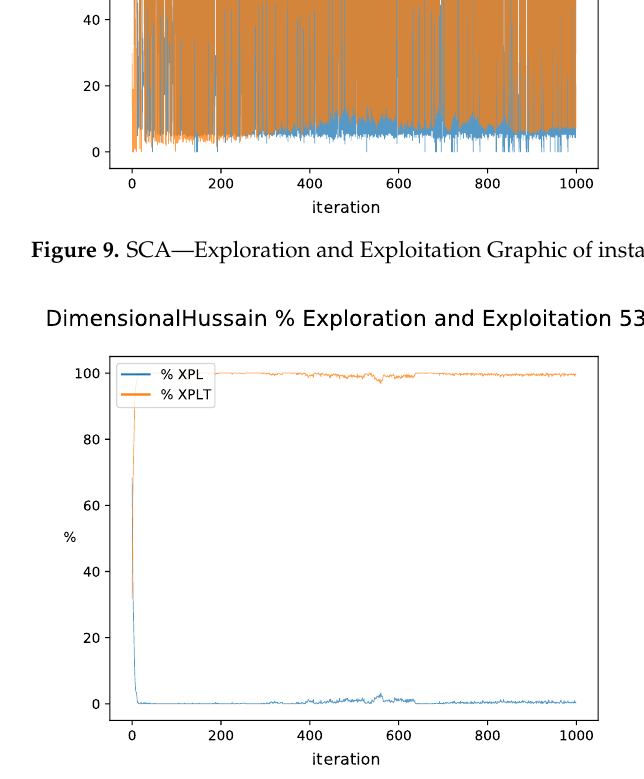
Figure 10. SCA—Exploration and Exploitation Graphic of instance 53 version